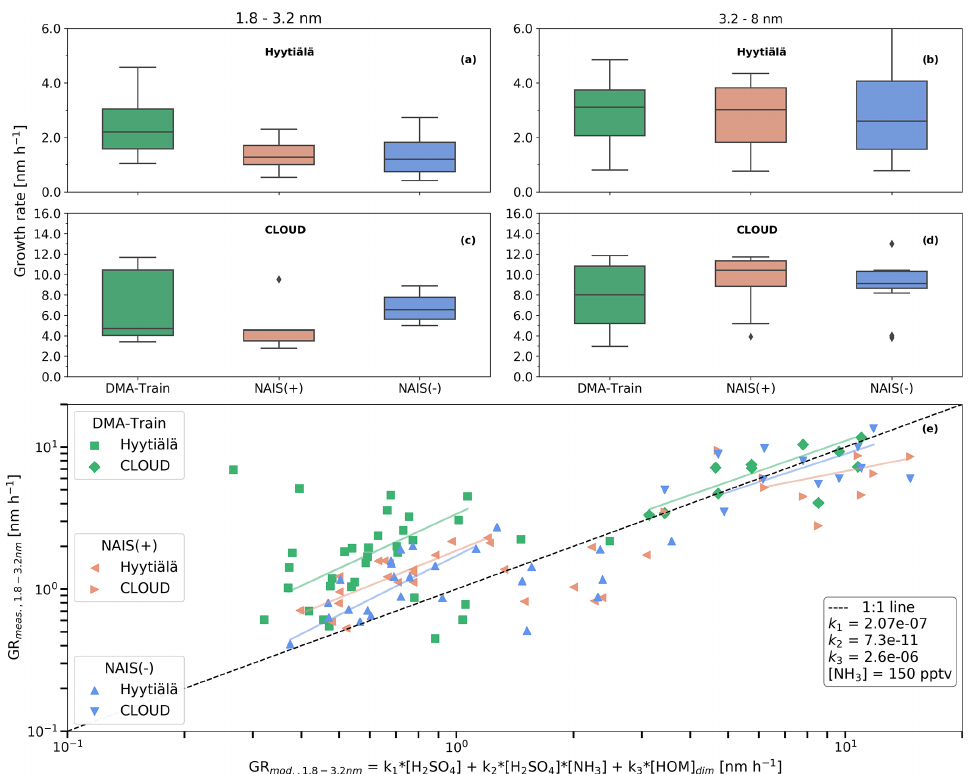
Figure 2. Comparison between GRs from CLOUD (Lehtipalo et al., 2018) and Hyytiälä. Due to higher vapor concentrations at CLOUD, the overall GRs are somewhat higher in CLOUD than in Hyytiälä. We represent the same instrument data with the same color code (i.e., green for the DMA-train, salmon for NAIS positive mode and blue for NAIS negative mode). Upper panels (a–d) are box plots of the growth rate distribution during Hyytiälä (“strong” NPF events only) and CLOUD campaign, showing the median growth rate and 25–75 percentiles of the data as horizontal black line and boxes and the 5–95 percentiles as error bars and strong outliers as diamonds. Lower panel (e) shows all available growth rate measurements during both campaigns in relation to the total condensing vapour and their corresponding growth rate according to Eq. (3), with the green squares as the DMA-train data from Hyytiälä and the green diamonds the DMA-train data from CLOUD. NAIS growth rate data are displayed as triangles, with the orientation indicating if Hyytiälä or CLOUD data are